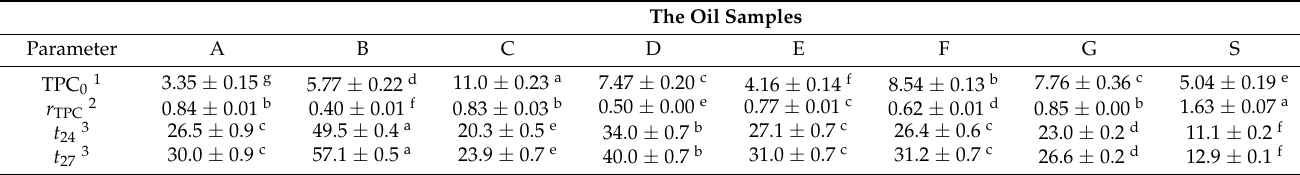
Table 1. The parameters resulting from the linear changes in the total content of polar compounds (TPC, %) over the frying time ( t , h) at 170 ◦ C for the oil samples A–S. The Oil Samples